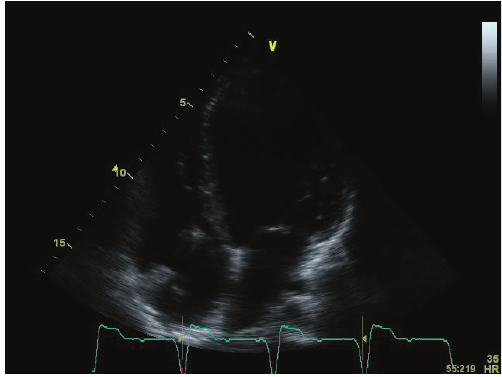
Figure 3: ETT showing dilatation of left ventricle.